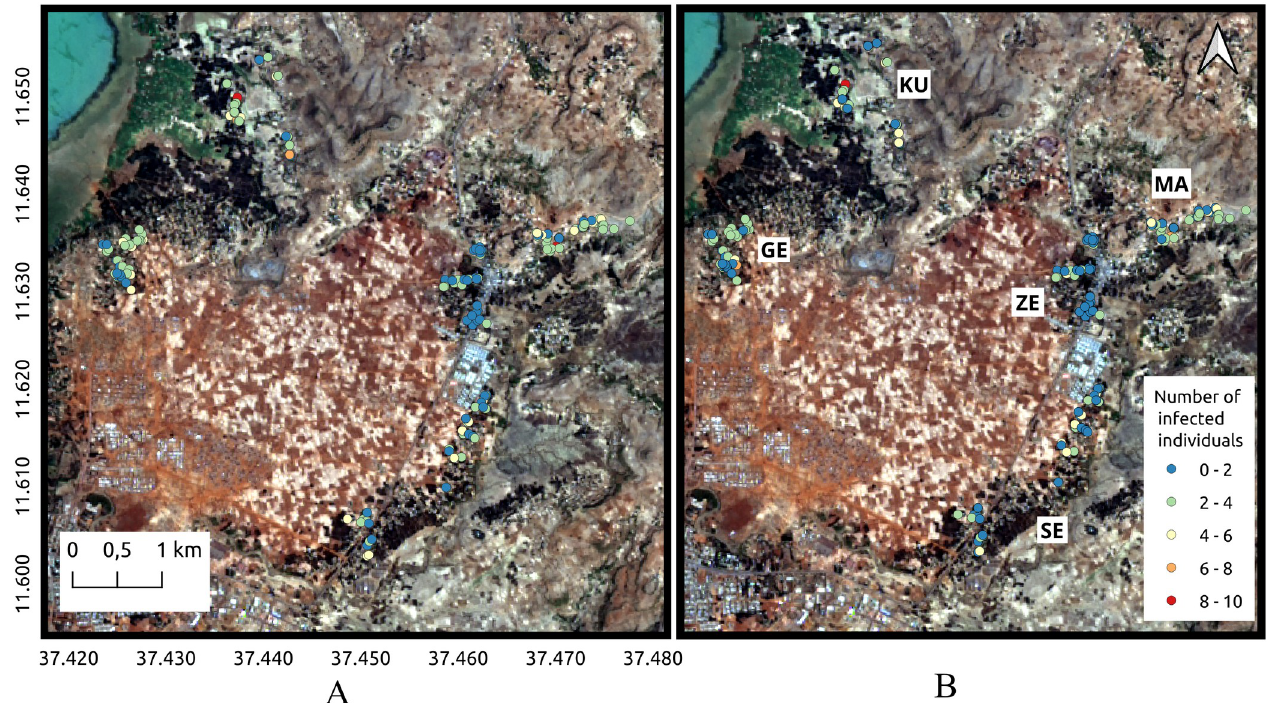
Fig 7. Map of the number of the hookworm infected individuals predicted (A) and observed (B) per household in the five villages. GE: Gedro, KU: Kurbi, MA: Mazoria, SE: Sesaberet, ZE: Zenzelema. Landsat-8 images, "Image courtesy of the U.S. Geological Survey", downloaded from the US Geological Survey server (USGS, https://www.usgs.gov) using Earth Explorer platform (https://earthexplorer.usgs.gov). The geographical location for Landsat-8 is: Path 170, Row 52. DATE_ACQUIRED = 2016-03-10.